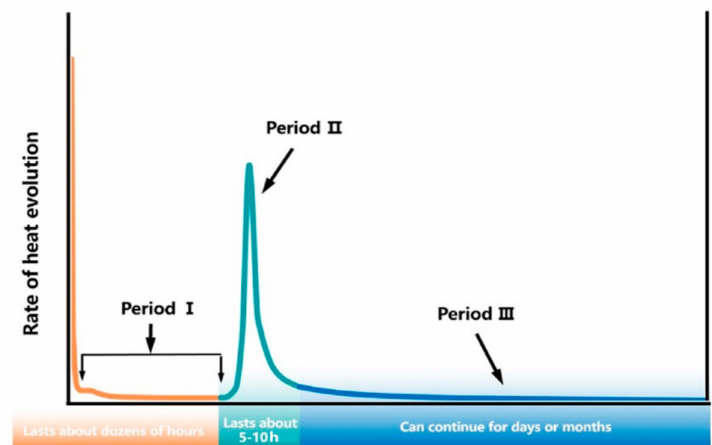
Figure 13. Schematic diagram of C 3 A hydration